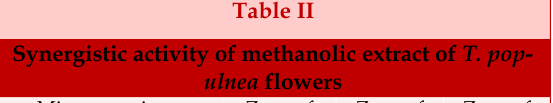
Synergistic activity of methanolic extract of T. pop- ulnea